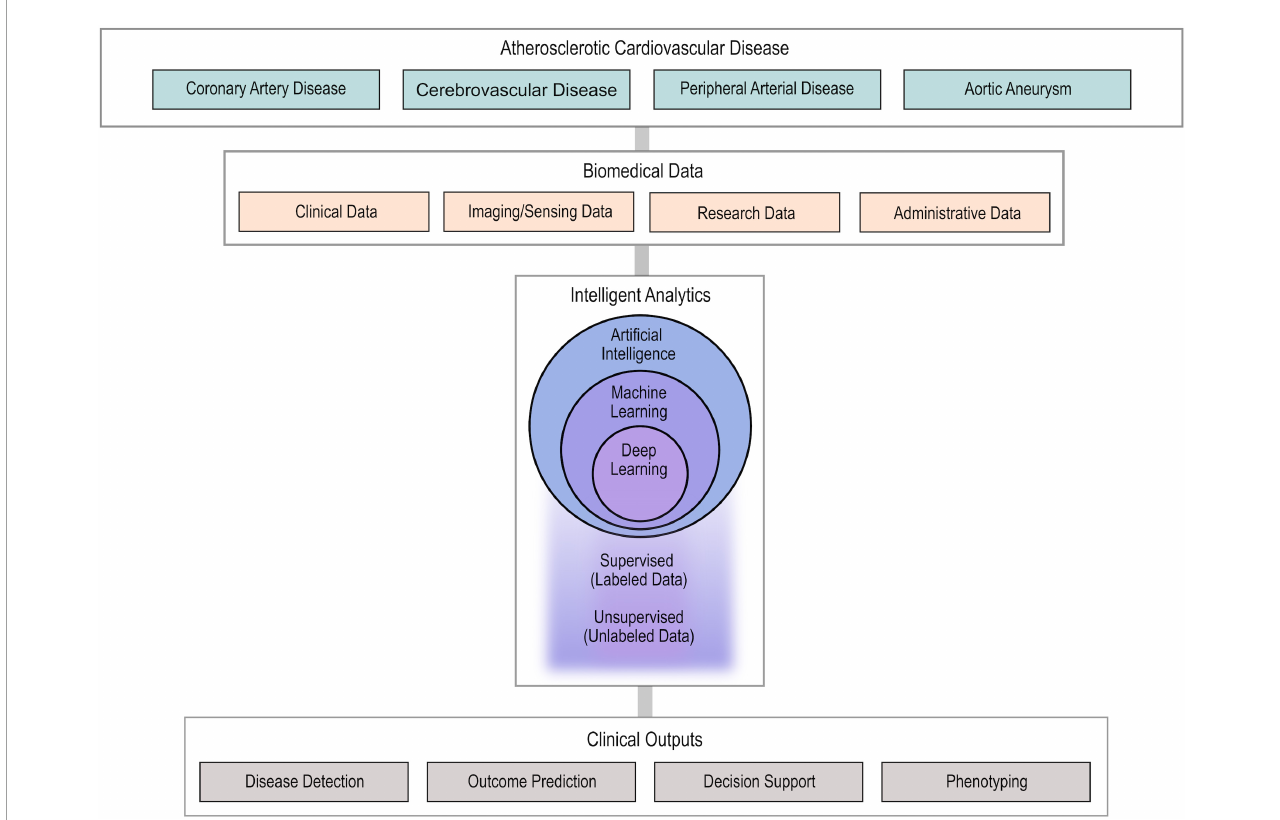
FIGURE1 Usual workflow of AI approaches in ASCVD. Highly diverse biomedical data from patients with ASCVD are collected and used as input in AI algorithms to provide intelligent analytics. The developed AI algorithms (ML and DL) undergo supervised or unsupervised training to enable disease detection, outcome prediction, clinical decision support, and phenotyping. AI, artificial intelligence; ASCD, atherosclerotic cardiovascular disease; ML, machine learning; DL, deep learning.